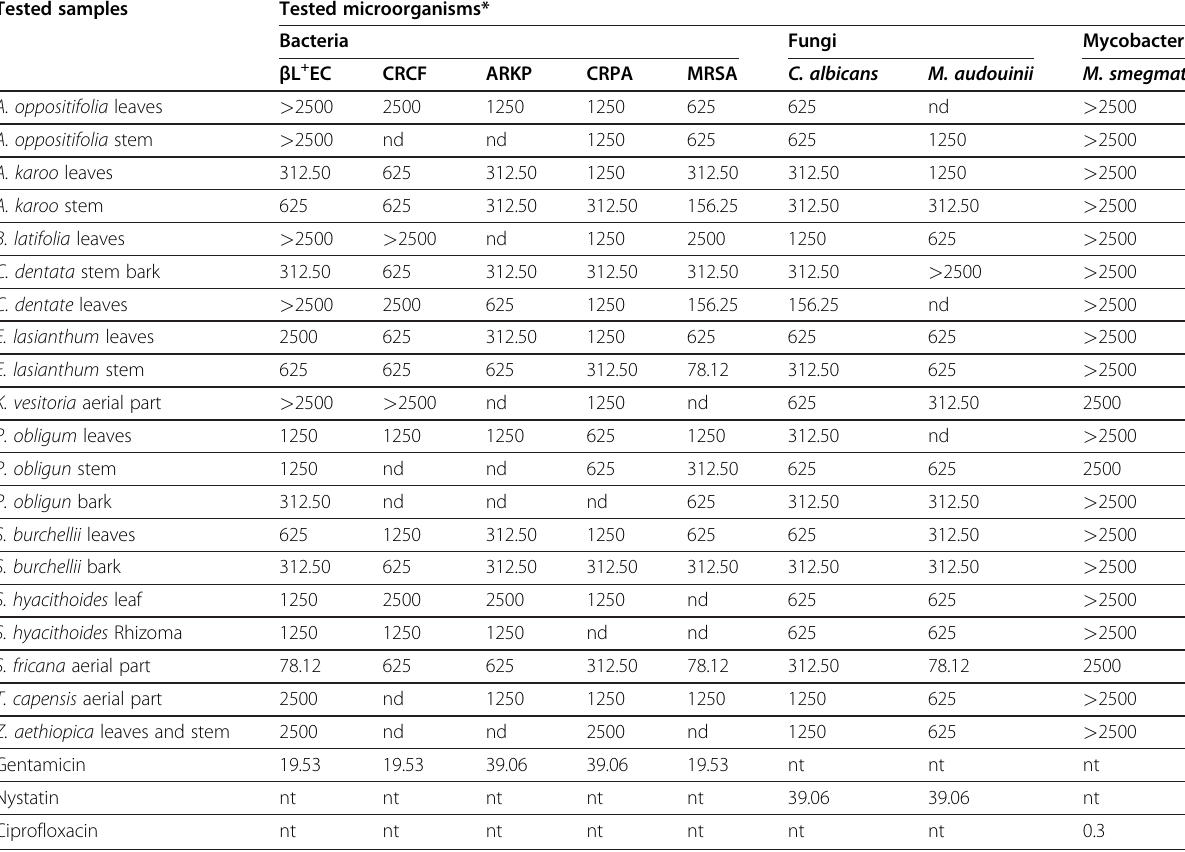
Table 3 Minimal microbicdal concentration ( μ g/ml) of the crude extracts and reference antibiotics Tested